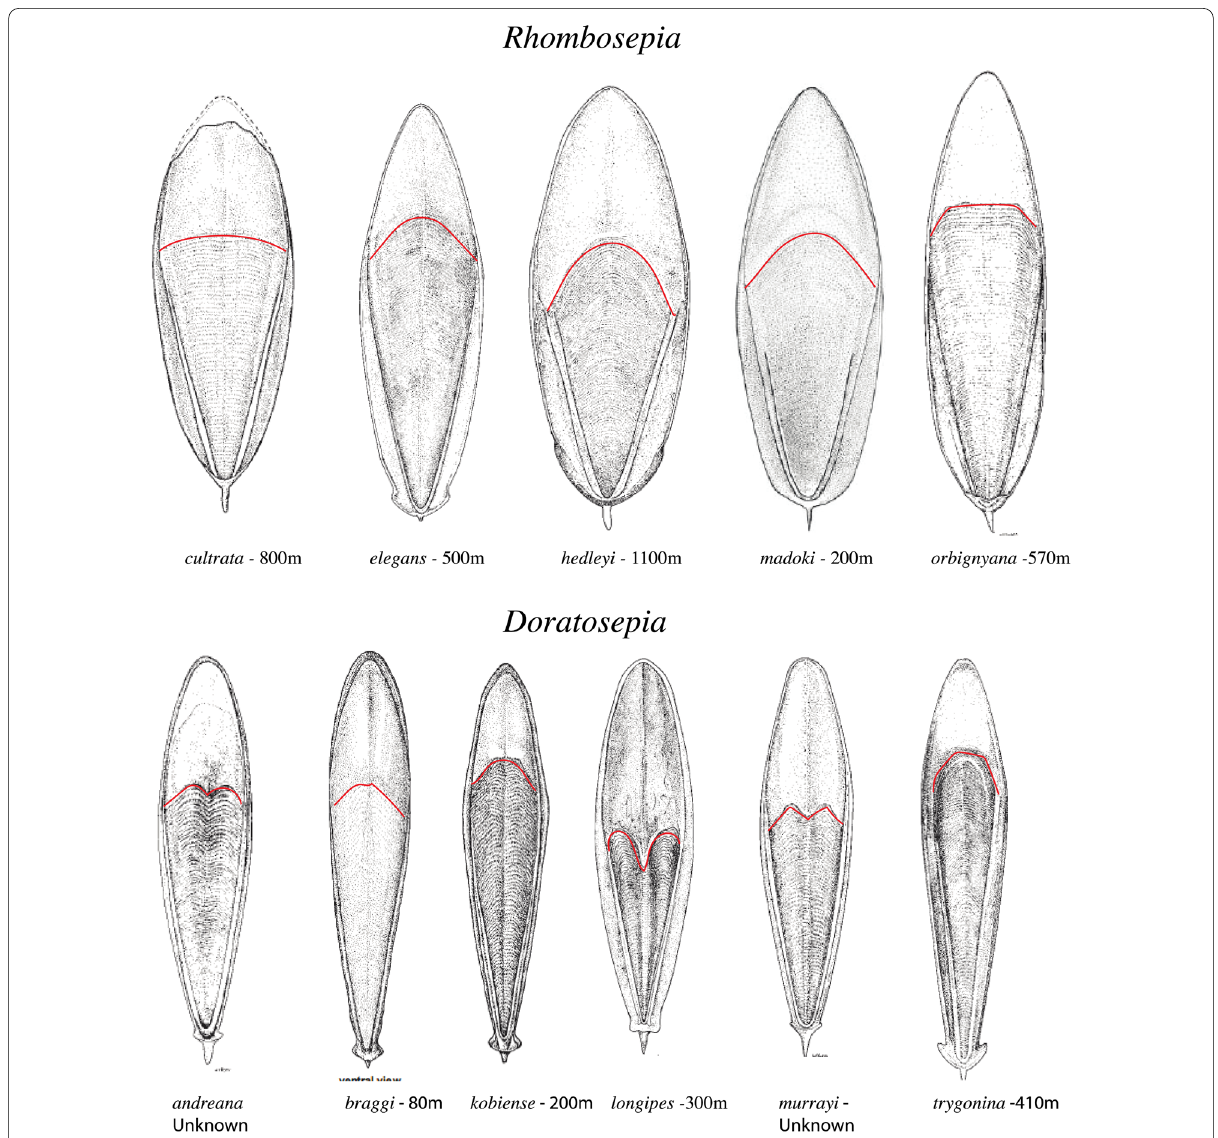
Fig. 7 Cuttlebones of Rhombosepia and Doratosepia “subgenera” from Khromov. These morphologies include the deepest inhabiting of all